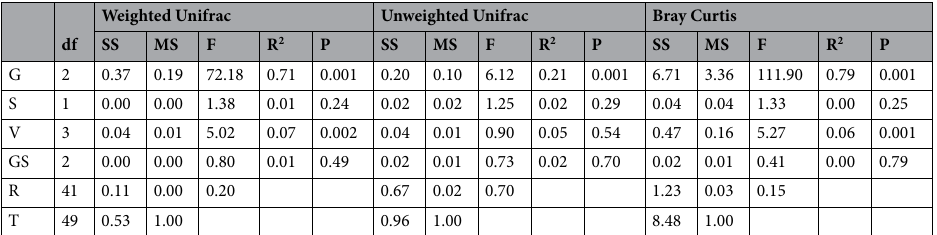
Table 1. Genotype and sex-dependent differences in microbiota composition of control and park 25 mutants. Effects of fly genotype (G), fly sex (S), fly vial (V), and the G-S interaction (GS) are shown along with residuals (R) and totals (T) as determined by PERMANOVA. PERMANOVA values are degrees of freedom (df), sum of squares (SS), mean squares (MS), F statistic (F), R 2 value ( R 2 ), and P -value ( P ).